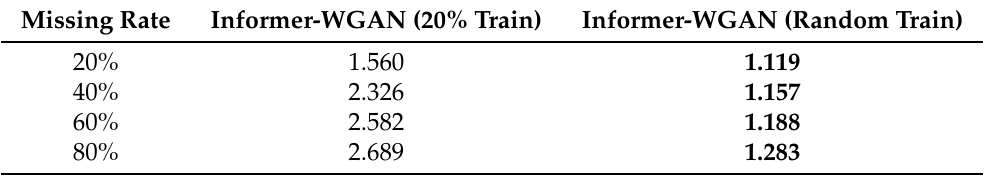
Table 11. The ablation experiment results (PRMSE) of different training methods on electricity